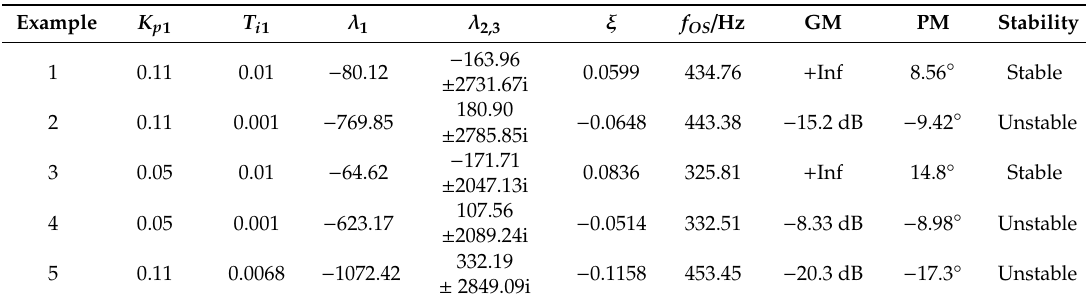
Table 2. Eigenvalues, the damping ratio, and stability margin of the five sets examples of MPPT control parameters in simplified structure (SS).